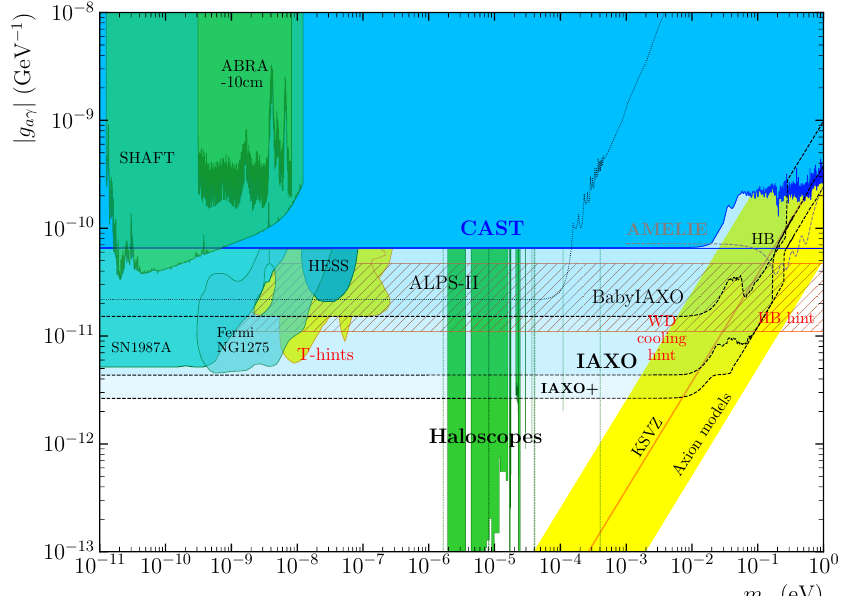
Figure 5. A plot of g a γ vs. m a , with the most stringent results (solid) and sensitivity prospects (dashed) of observations and experiments, directly comparable with the previous Figure 2. Prospects of different phases of IAXO are shown, BabyIAXO, IAXO, and an upgraded version of IAXO, IAXO+. Other experimental prospects with potential to explore new regions of the parameter space are also included, as ALPS-II [68] or